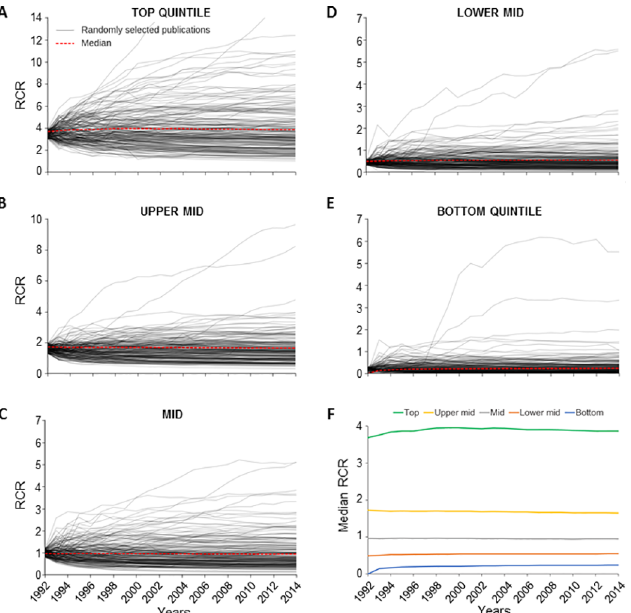
Fig 1. Stability of Relative Citation Ratio (RCR) over time. (A–E) Changein RCR over time was determined for individualNationalInstitutes of Health (NIH)-funded articles publishedin 1991. Articles were assignedto quintilesbased on their RCR values in the year after publication (1992); RCR in each subsequent year was calculated. For each quintile,200 individual articles (gray lines) were chosen at random from the subset in which the 1992 values were within 10% of the median,and the resultingplots are shown. All values are actual and unsmoothed. In (A) through (E), the red line shows the medianfor the respectivequintile.(A) Top quintile,(B) Upper mid quintile,(C) Mid quintile,(D) Lower mid quintile, (E) Bottom quintile,(F) Median RCR in each of the 5 quintilesfor all NIH-funded articles published in 1991. See S1